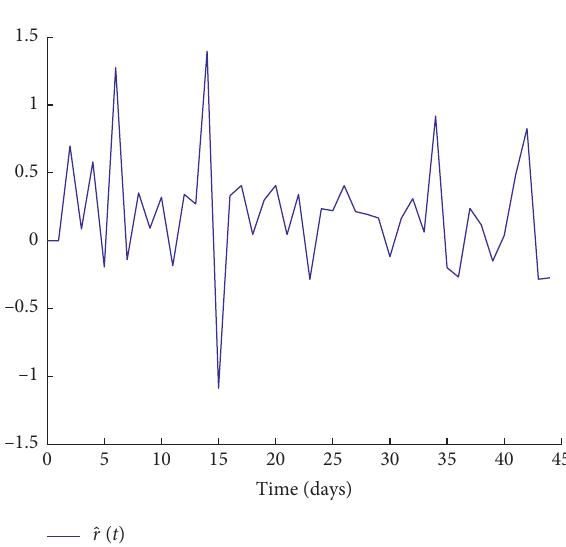
Figure 10: Estimation of the Malthusian parameter from reported data (Italy).